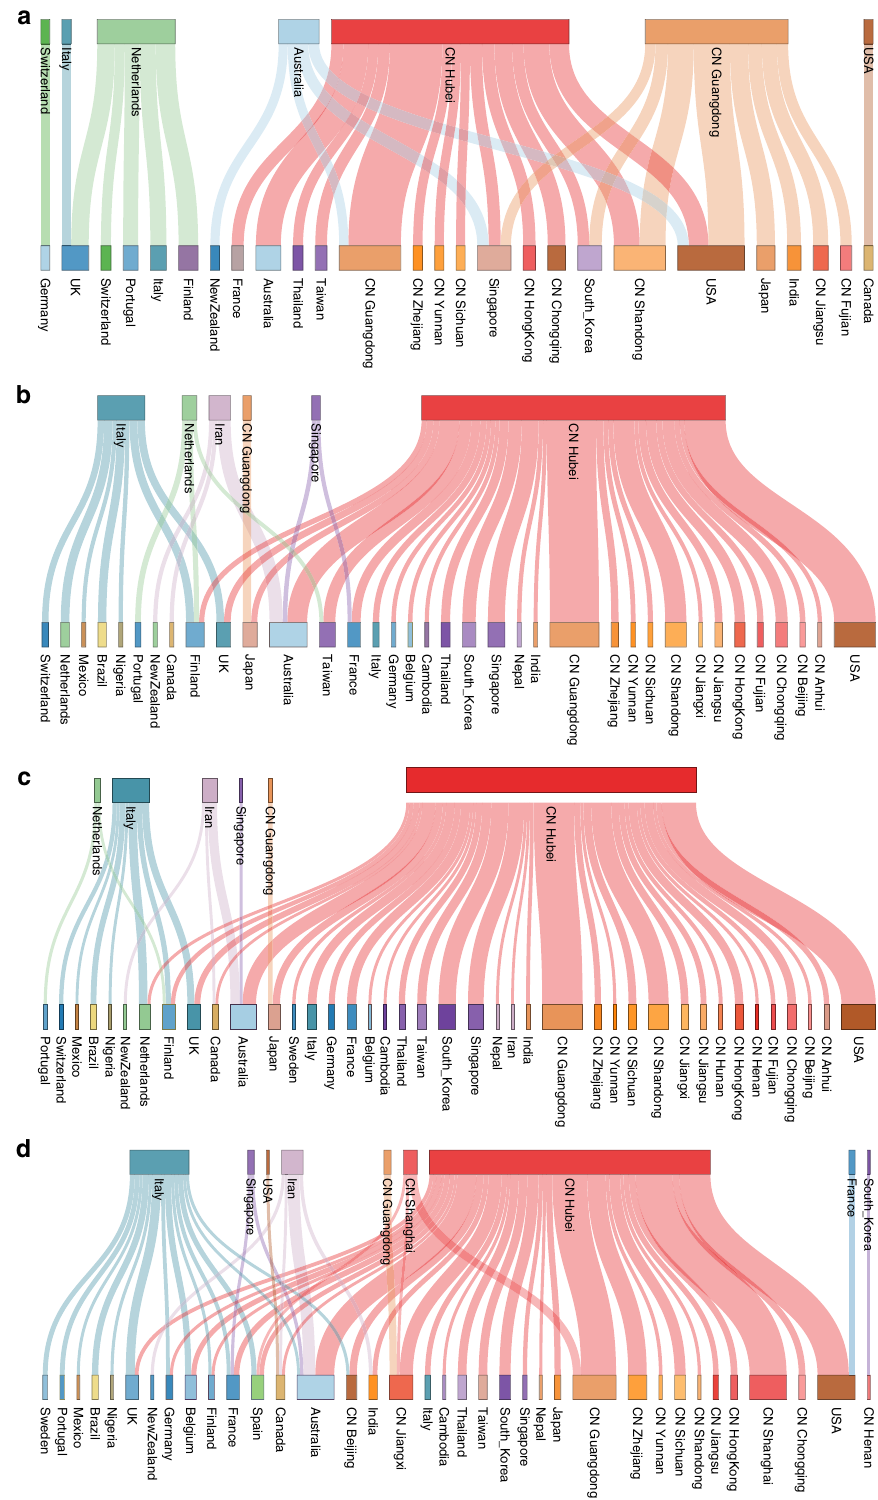
Fig. 6 Sankey plots summarizing Markov jump estimates for the analyses of the 282 genome data set. The reconstructions use a sampling location only, b sampling location and travel history, and c sampling location and travel history with unsampled diversity, and d for the analysis of the 500 genome data set using sampling location and travel history. The plots show the relative number of transitions between origin (top) and destination (bottom) locations. We note that locations may both be origin locations (in the top row) and destination locations (in the bottom row), and there is no temporal order for the transitions involved. For summaries that show all transitions to and from a location connected to that particular location, we refer to the circular migration plots in Supplementary Fig.